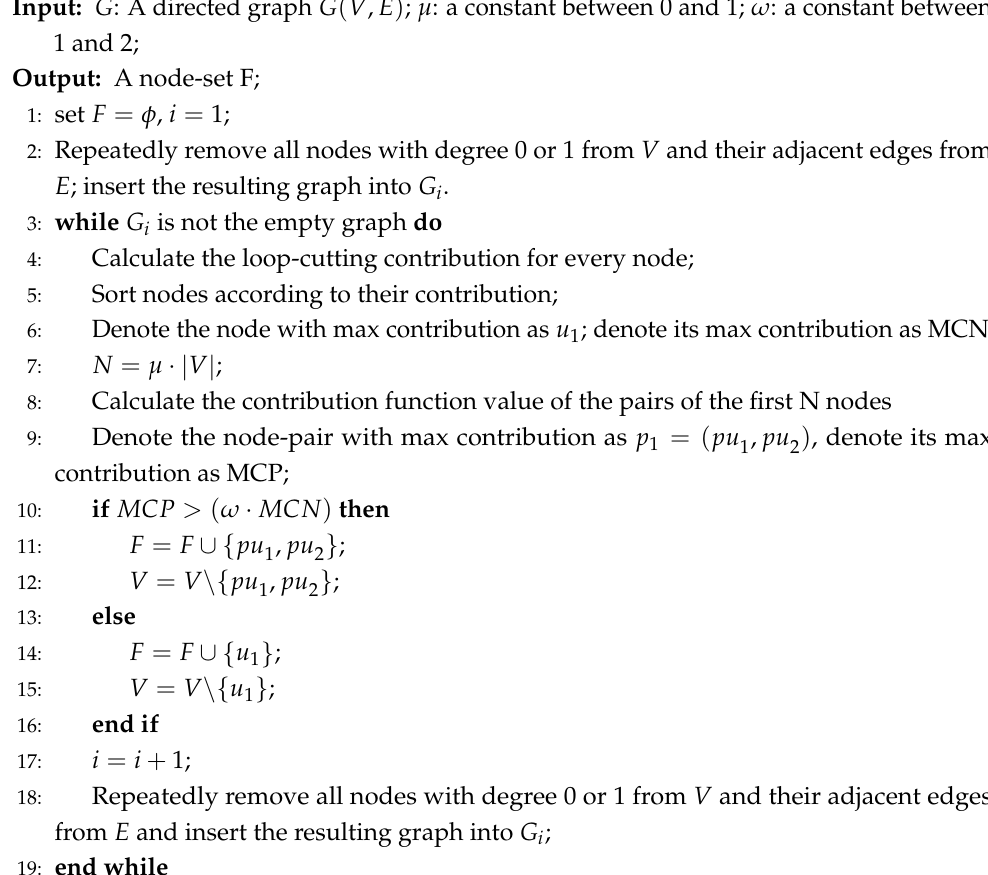
Algorithm 1 Contribution Function Algorithm